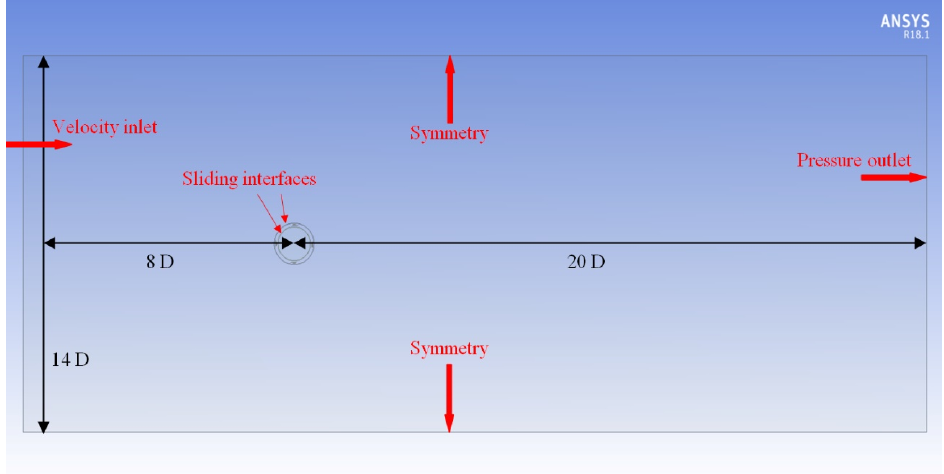
Figure 2. Experimental setup and detail of the mechanical brake system.